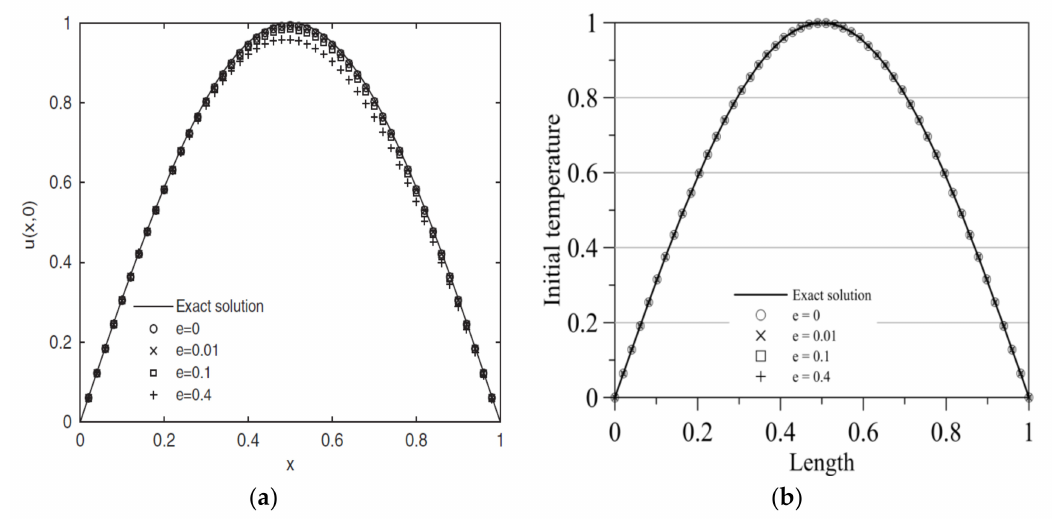
Figure 12. The estimated initial temperature with noise level: ( a ) the space–time multiquadric (MQ) method; ( b ) this study.